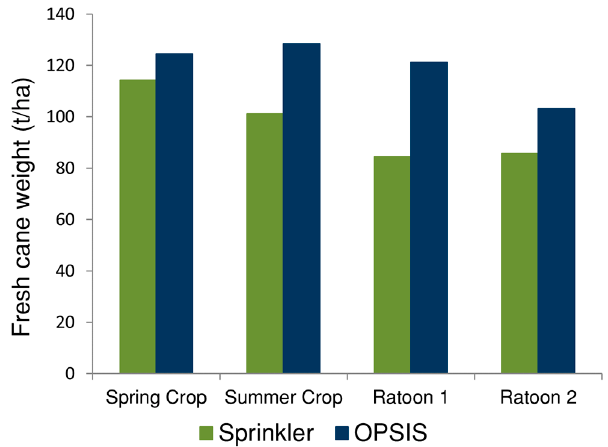
Figure 4. Fresh cane yield of sugarcane cultivar Ni21 as affected by irrigation method.